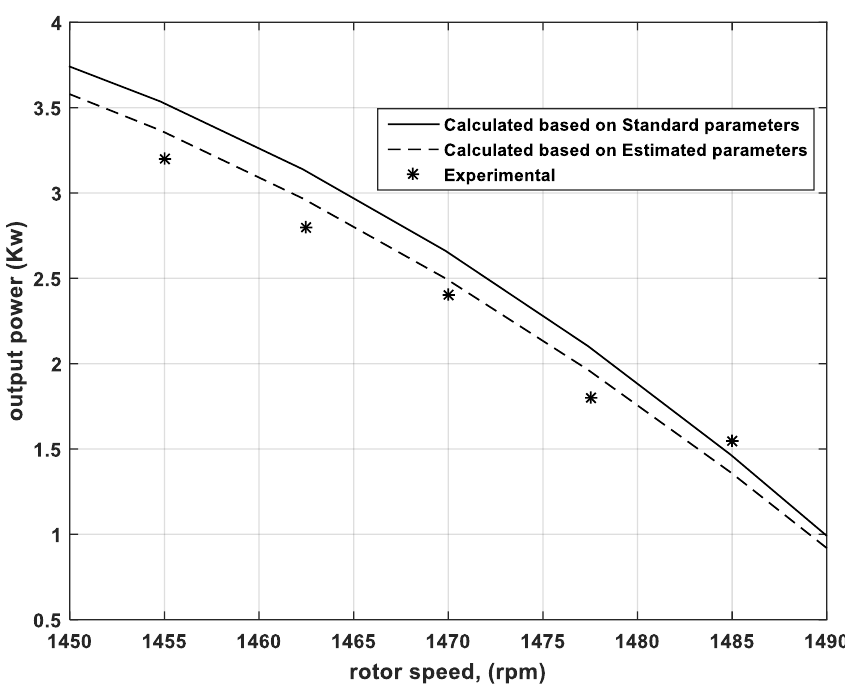
Figure 12. Variation of output power versus motor speed.